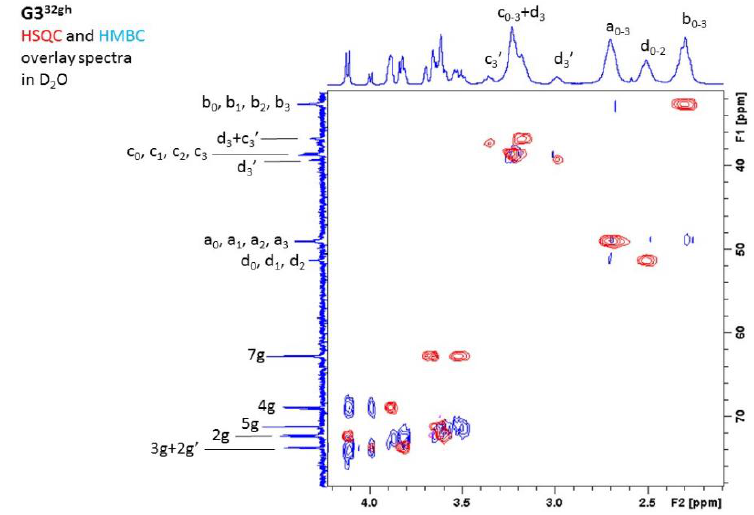
Figure A2. 1 H- 13 C HSQC (red cross-peaks) and HMBC (blue cross-peaks) spectra of G3 32gh in D 2 O.